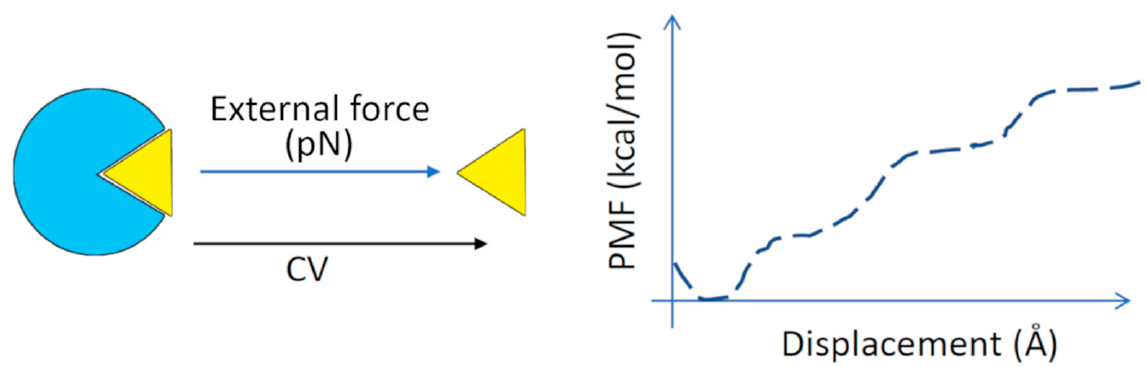
Figure 7. Steered molecular dynamics (SMD). A continuous external force is used to pull the ligand out of the target protein binding site along the reaction coordinate (‘collective variable’, CV). The free energy of binding is calculated from the relationship between the force used and the displacement of the ligand. The plot of average potential energy versus displacement is called the potential of mean force (PMF) [210]. Enhanced MD simulations (e.g., as umbrella sampling) coupled with the weighted histogram analysis method (WHAM) are used to determine the PMF along the reaction coordinate.